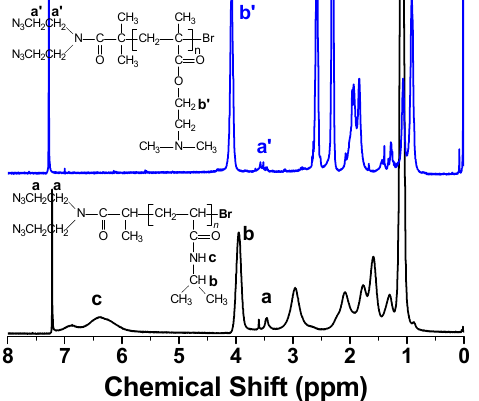
Figure 2. The 1 H-NMR spectra of PDMAEMA 60 –(N 3 ) 2 (upper) and PNIPAM 60 –(N 3 ) 2 (lower) in CDCl 3 . Table 1. Characterization results of PDMAEMA–(N 3 ) 2 and PNIPAM–(N 3 ) 2 macro-cross-linkers. Polymer